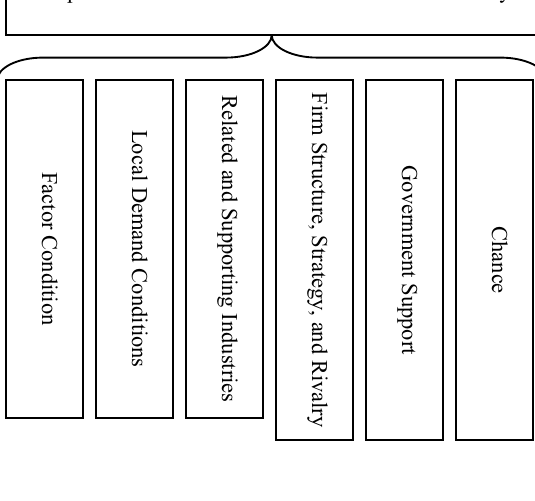
Figure 1 Research Framework